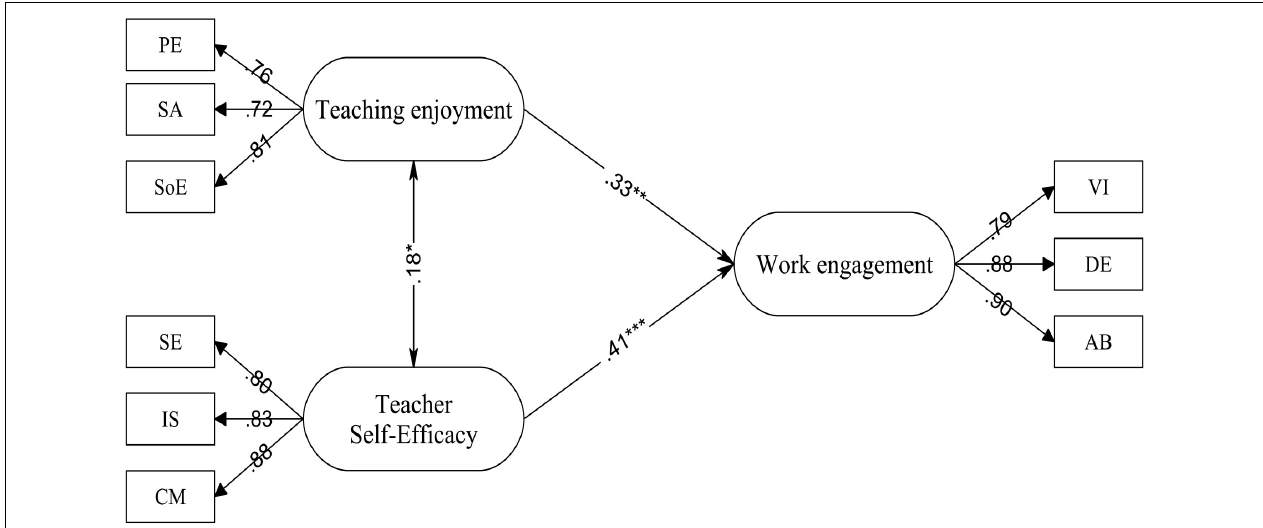
FIGURE 1 | The final model of teacher self-efficacy, teaching enjoyment, and teacher work engagement. * p < 0.05; ** p < 0.01; *** p < 0.001.